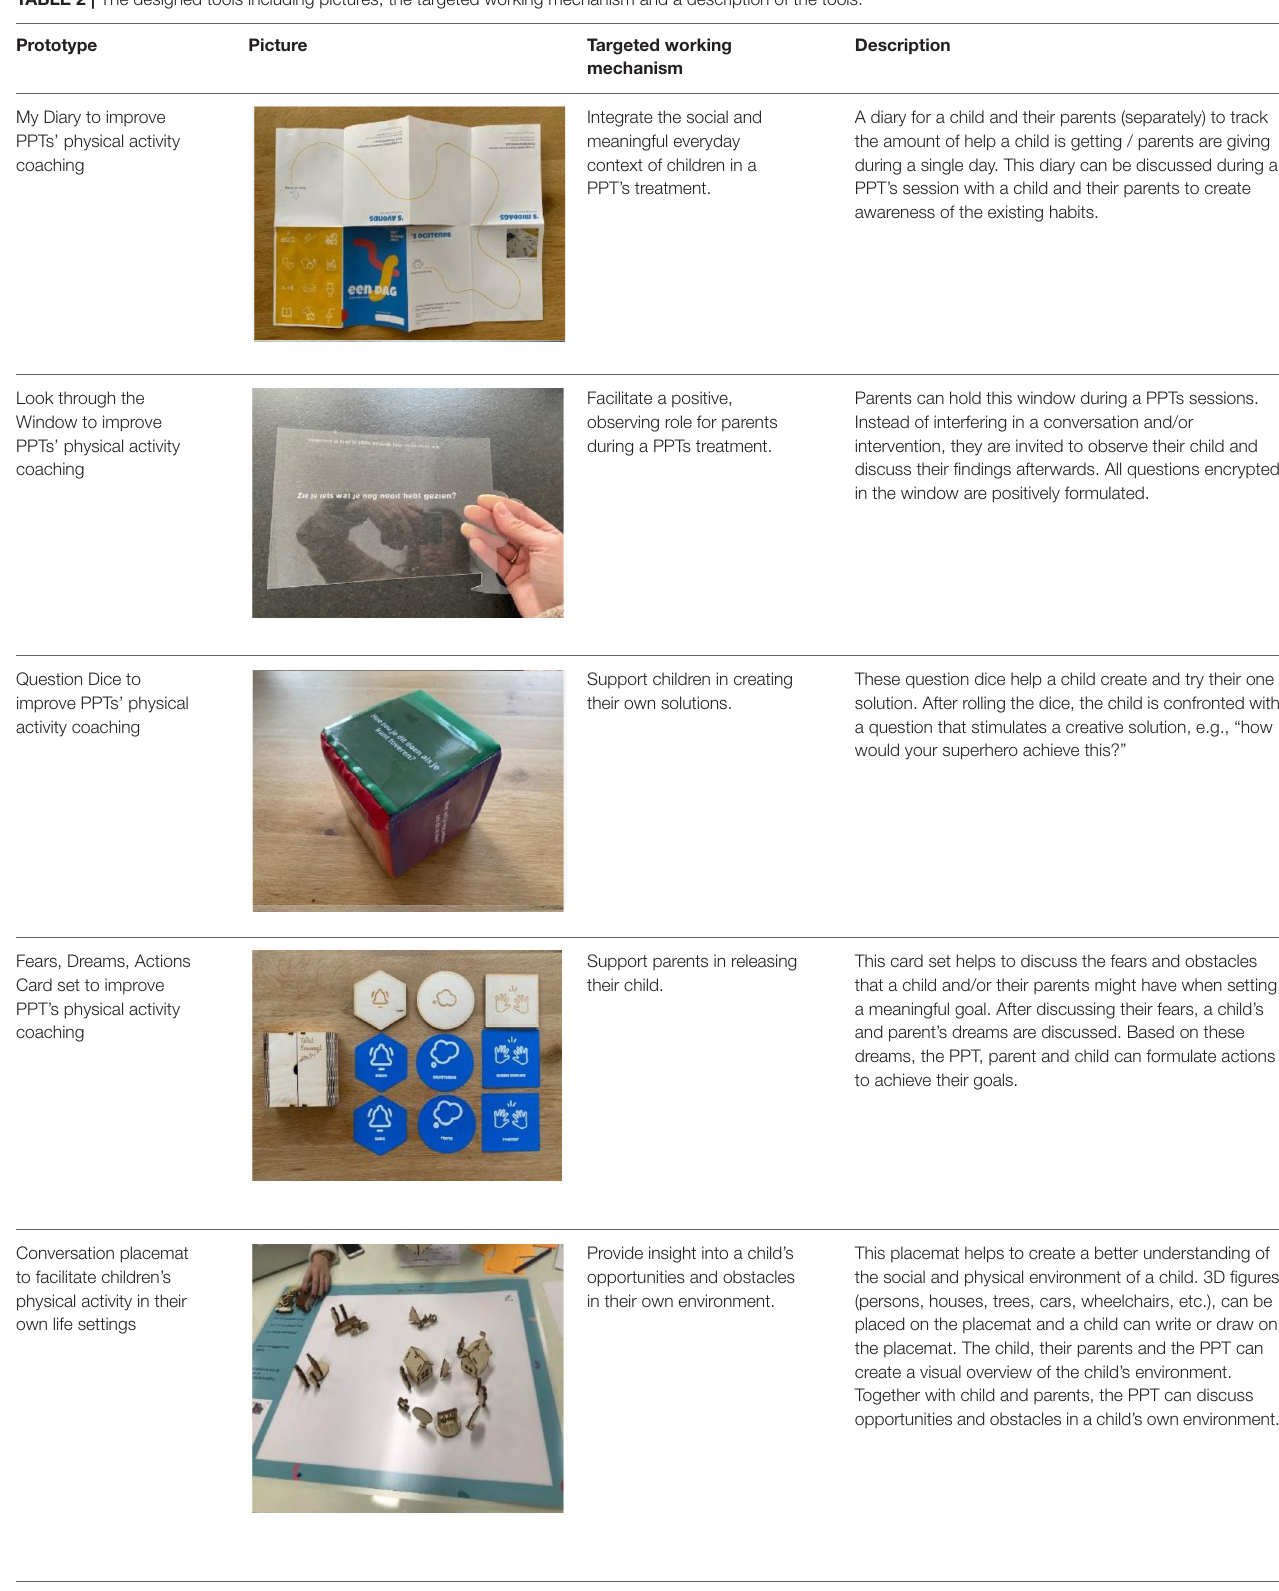
TABLE 2 | The designed tools including pictures, the targeted working mechanism and a description of the